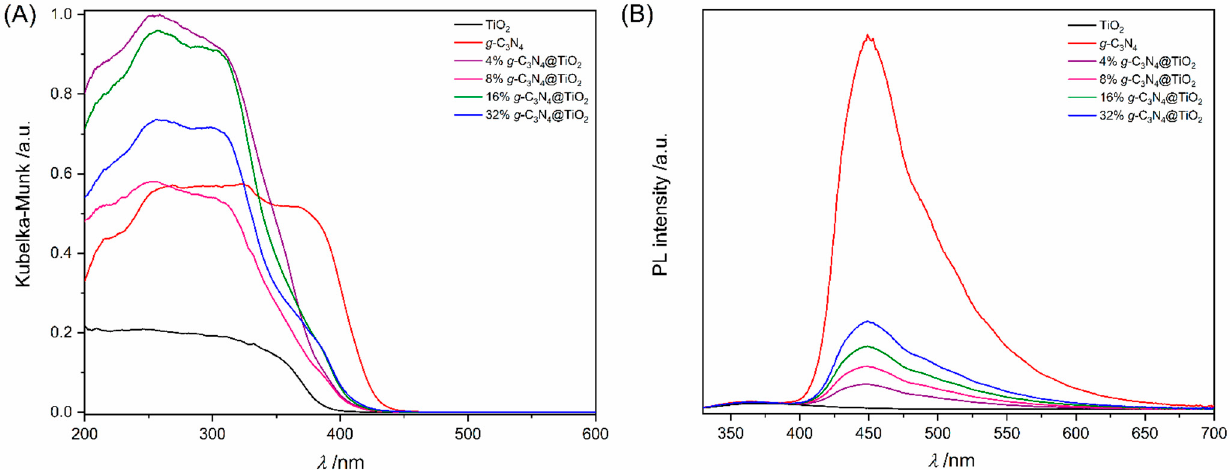
Figure 3. ( A ) The UV–Vis diffuse reflectance spectra and ( B ) room temperature photoluminescence (PL) spectra with 300 nm excitation for the synthesized g -C 3 N 4 , TiO 2 , and their nanocomposites. Table 1. Band gap energies (Eg) of prepared